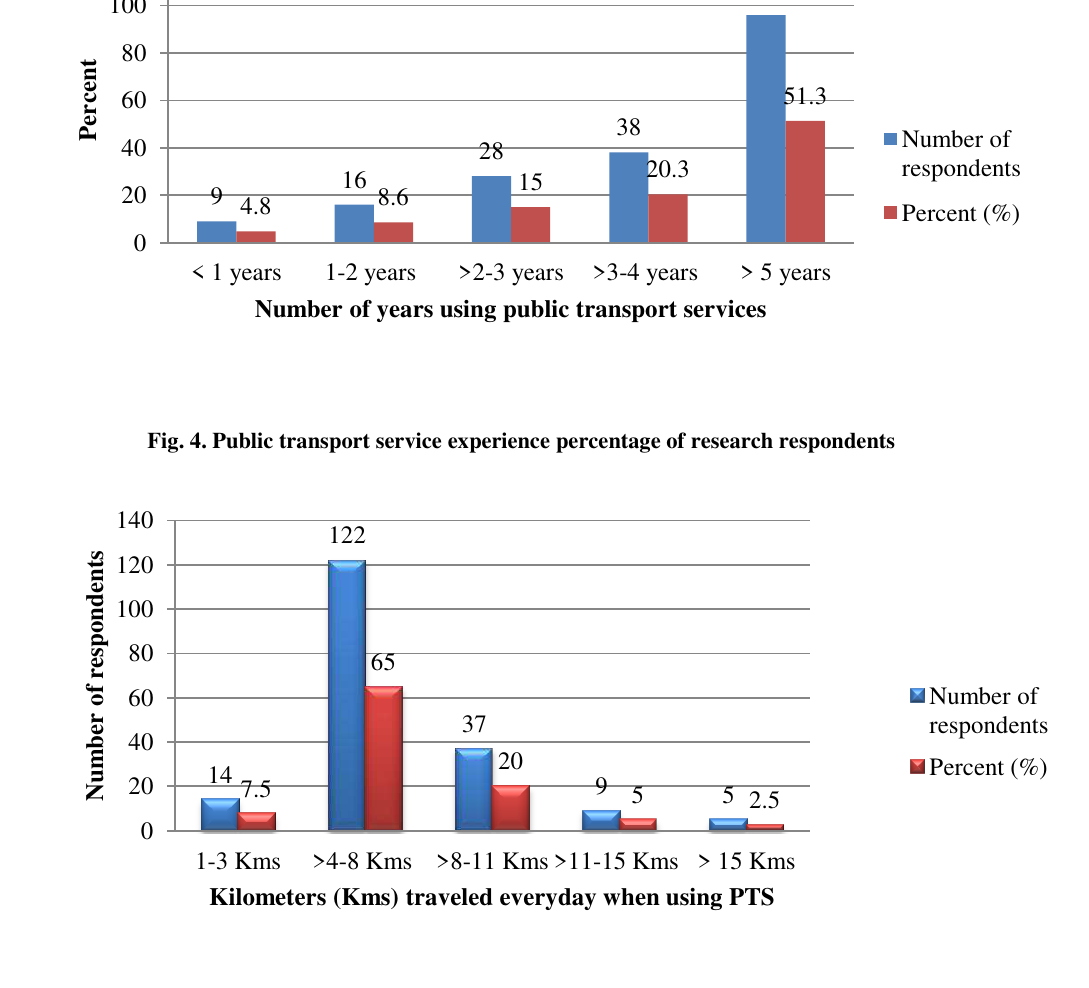
Fig. 5. Distance traveled everyday when using PTS percentage of research respondents 3.3. Preliminary question.